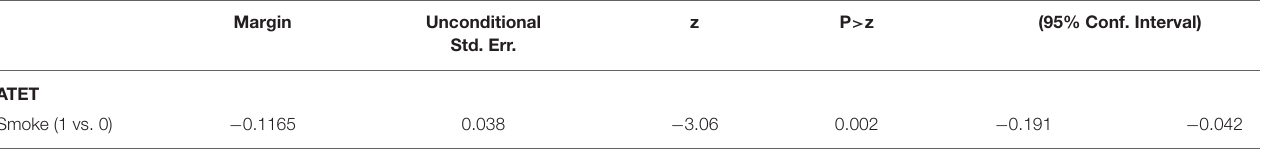
TABLE 4 | ATET estimates of smoking on the HRQoL: IV probit model. Margin Unconditional Std.